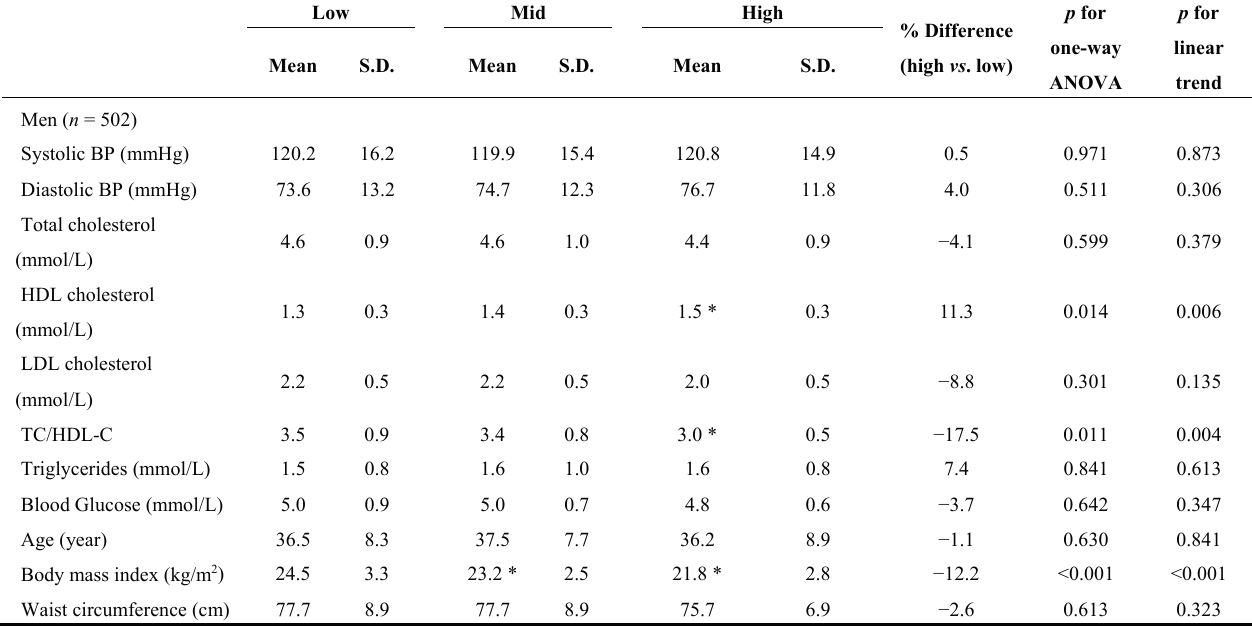
Table 2. Comparison of means of parameter by three DF intake